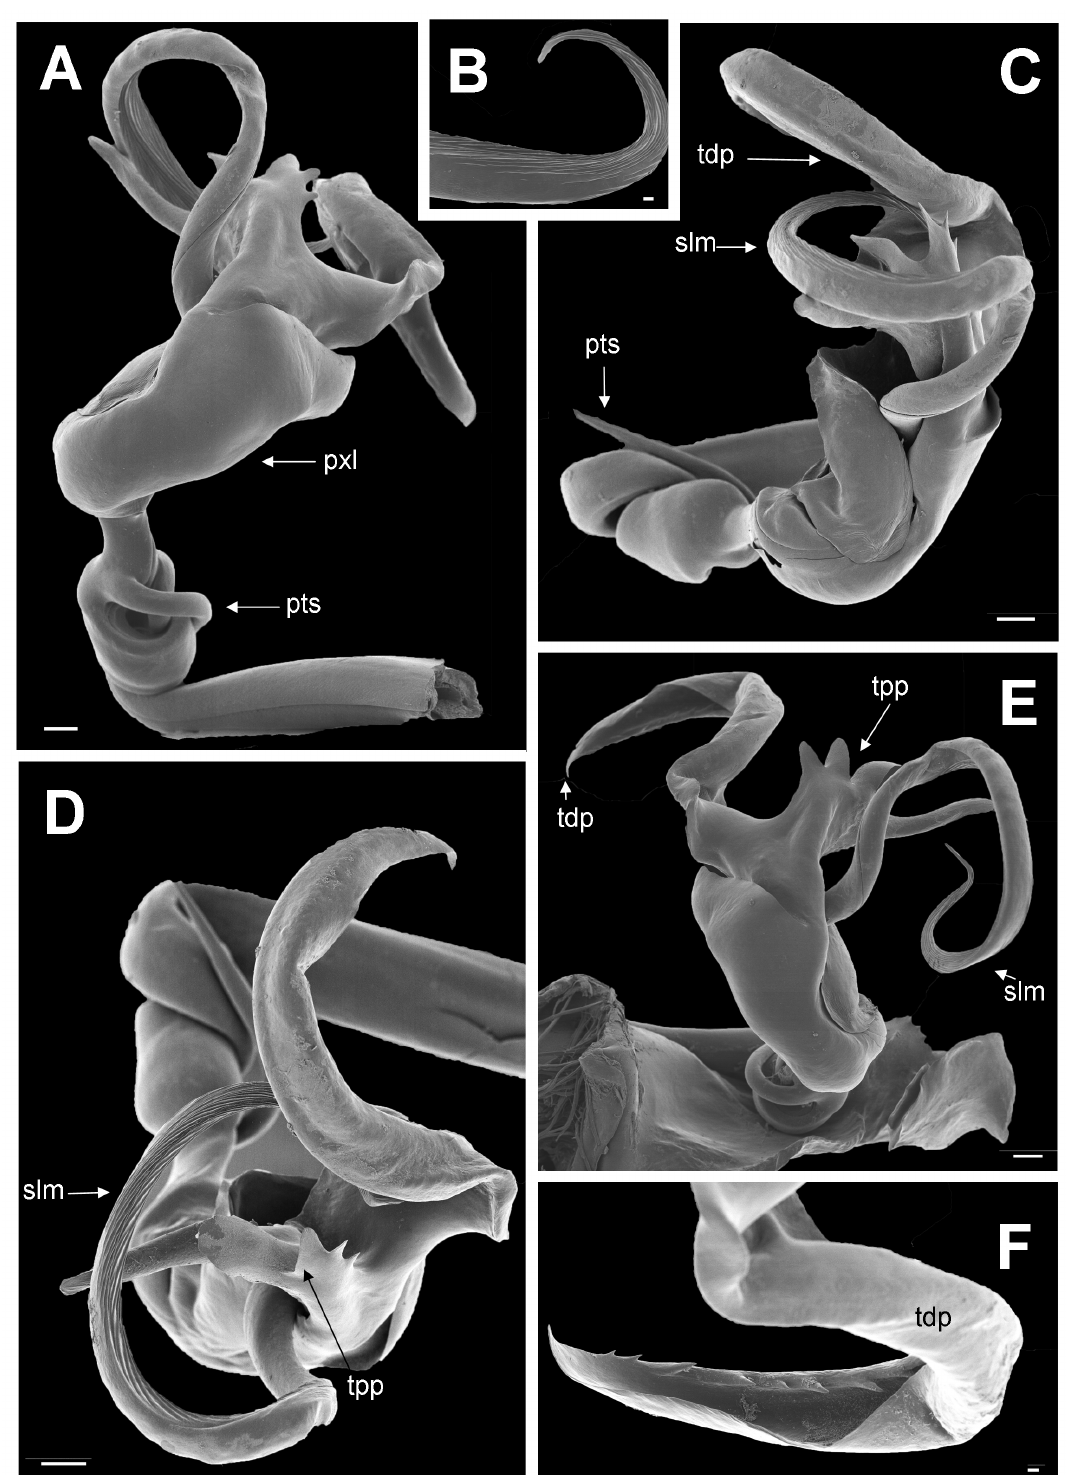
Fig. 6. Prionopetalum kraepelini (Attems, 1896), specimen from Mang’ula, 339 m asl. Gonopod telopodite. A , C – D , F . Right gonopod telopodite. A. Posterior view. C. Apical (ventral) view. D. Anterior view. F. Telomere distal process. B . Tip of left solenomere. E . Left gonopod, (posterior-) mesal view. Abbreviations: pts = post-torsal spine; pxl = proximal lobe of telomere; slm = solenomere; tdp = telomeral distal process; tpp = telomeral proximal process. Scale bars: A, C–D, E = 0.1 mm; B, F = 0.2